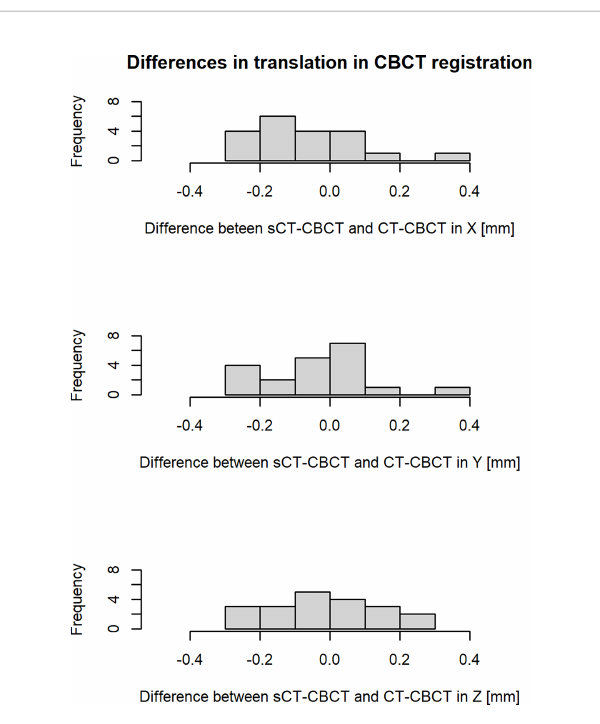
FIGURE 3 | Differences in translation (X, Y, Z) in the image registration of sCT-CBCT compared to CT-CBCT for all patients. The X, Y and Z axis correspond to the following translations: X=left to right, Y=anterior to posterior and Z=superior to inferior. The histogram cells include their right- hand endpoint.